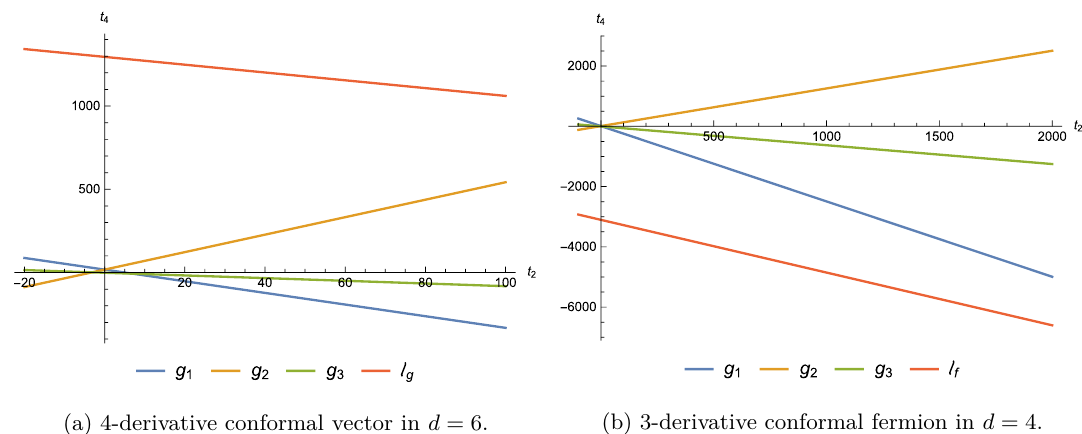
Figure 7 . The region of causality is the small triangle where g 1 , g 2 and g 3 meet near the origin. of it with respect to q at q = 1 which are given in (5.63) and (5.64) respectively.